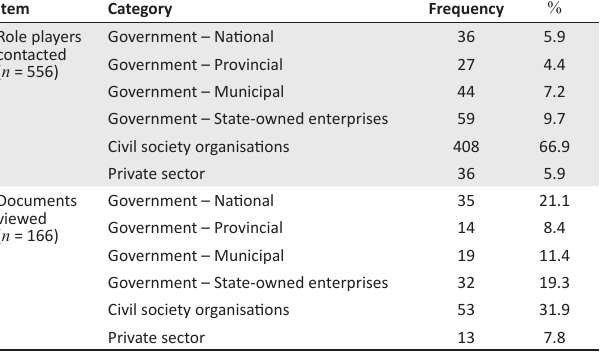
TABLE 2: Characteristics of participants and documents (participants: n = 610; documents: n =